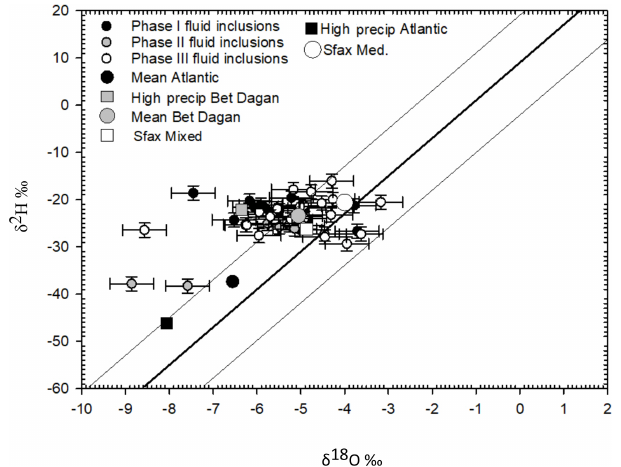
Figure 9. Fluid inclusion measurements relative to summarised precipitation data and the modern precipitation endmembers used in Sect. 4.1. Solid lines are the meteoric water lines as in Fig. 5a. Precipitation and fluid inclusion measurements are as shown in Fig. 5b. “Mean Atlantic”, “Sfax Mixed”, “Sfax Med” and “High Precip Atlantic” indicate the mean of measurements in Celle- Jeanton et al. (2001) originating from Atlantic moisture, mixed source, Mediterranean moisture and high precipitation measure- ments from an Atlantic moisture source (as described in Sect. 4.1) respectively. “Mean Bet Dagan” is the mean of GNIP measurements from this location, and “High Precip Bet Dagan” is the subset of high precipitation measurements as described in Sect. 4.1.